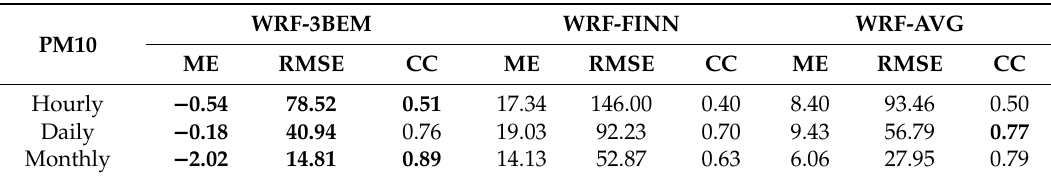
Table 5. Overall MEs (E[simulations-measurements]), RMSEs, and CCs of simulations and measurements for WRF-3BEM, WRF-FINN, and WRF-AVG simulated hourly, daily, and monthly average PM10 concentrations (μg m −3 ) for February–April of 2014 and 2015 evaluated using measurements from all 12 ground stations.